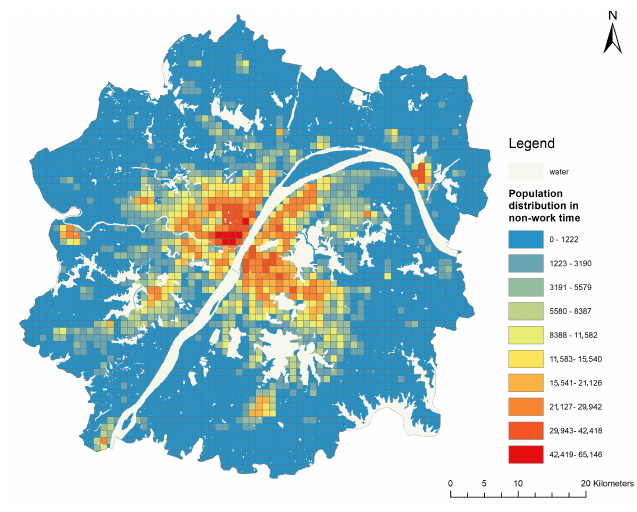
Figure 10. Population distribution in non-work